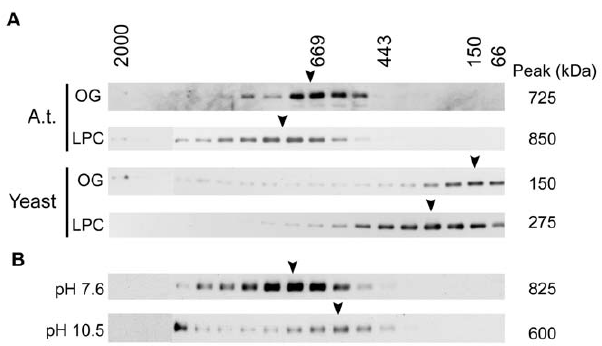
Figure 1. Gel-filtration analysis of ETR1 isolated from its native Arabidopsis or after transgenic expression in yeast. Microsomal fractions were solubilized with octylglucoside (OG) or lysophosphatidyl choline (LPC), and the proteins fractionated on Superose 6HR. ETR1 was detected by immunoblot analysis of the fractions. The estimated molecular mass of the ETR1 complex is indicated to the right of each immunoblot. Positions of the molecular mass markers used to calibrate the column are indicated above. (A) Elution profile of ETR1 from Arabidopsis (A.t.) from plants grown in liquid culture or after transgenic expression in yeast. (B) Effect of pH treatment upon size of the ETR1 complex from Arabidopsis. Microsomes were treated with buffers of either pH 7.6 or 10.5 prior to LPC-solubilization and gel-filtration analysis.